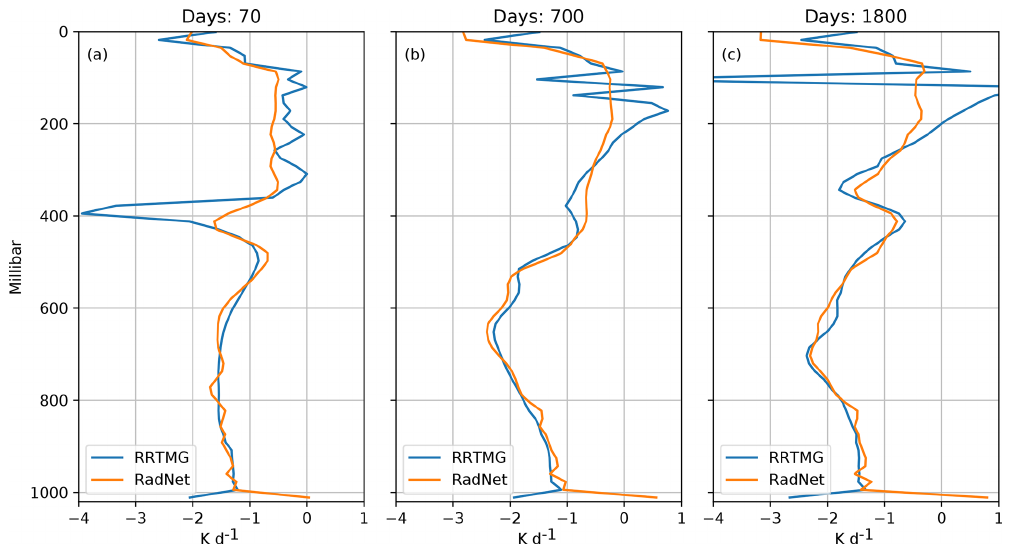
Figure 7. Comparison of the vertical profiles of longwave heating rates predicted by the NN and RRTMG for atmospheric profiles from the RadNet